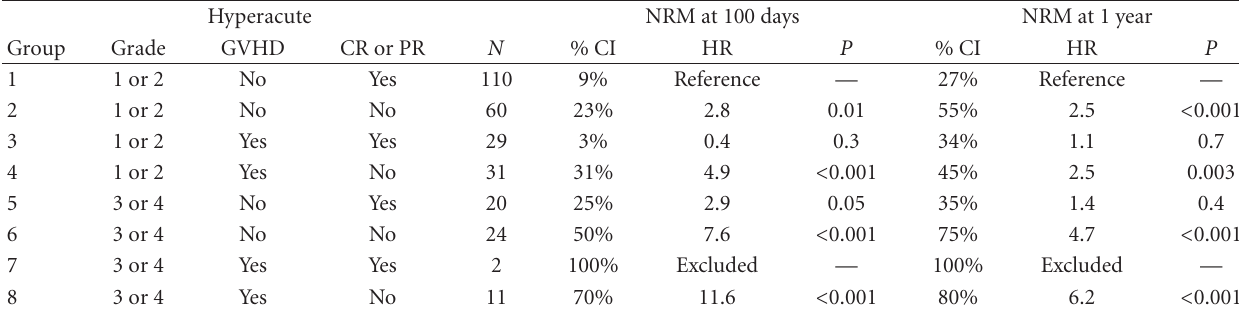
Table 6: The E ff ect of severity, hyperacute GVHD, and response to corticosteroids on nonrelapse morality. Hyperacute NRM at 100